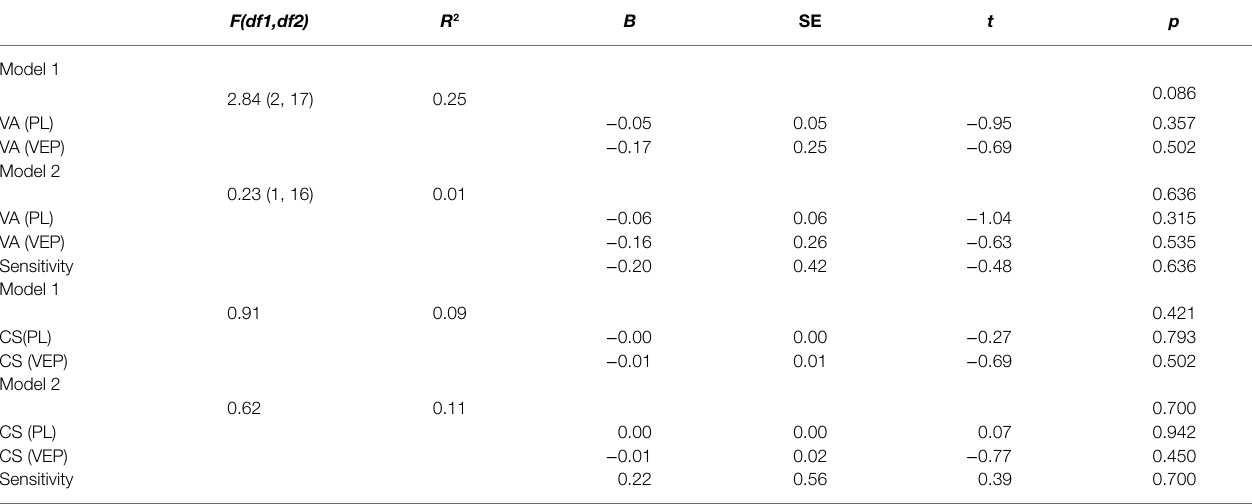
TABLE 1 | Regression analyses of VI and sensitivity contribution to dyadic